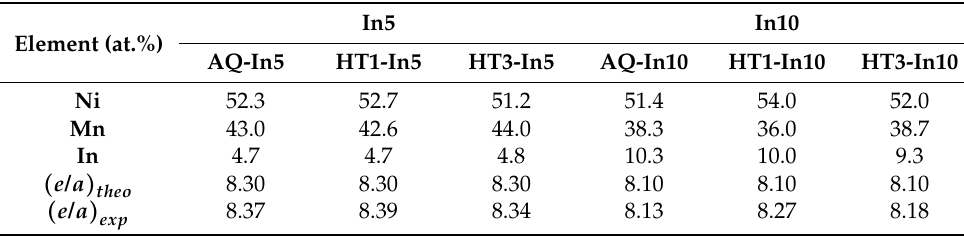
Table 2. Elemental analysis and e/a ratio (theoretical and experimental) of the as quenched and heat-treated In5 and In10